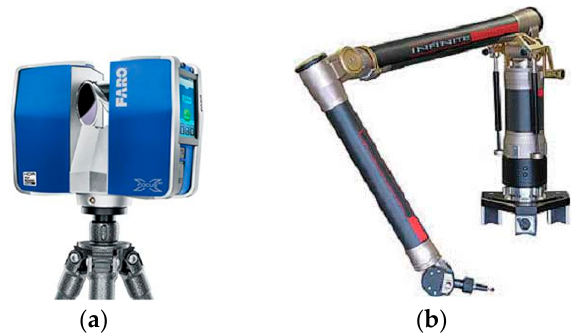
Figure 4. Equipment used in data acquisition: ( a ) FARO LS420 scanner; ( b ) CimCore Infinite 2.0 articulating arm.